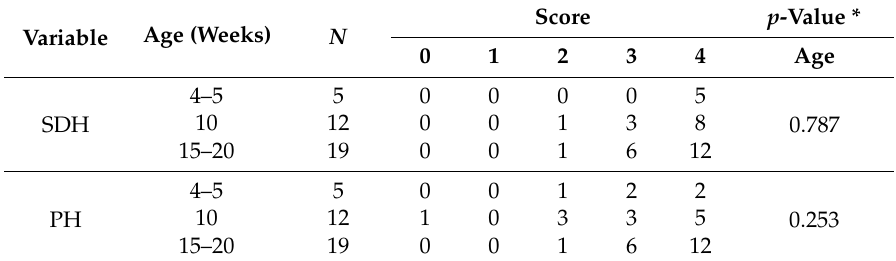
Table 9. Distribution of microscopic hemorrhage scores by